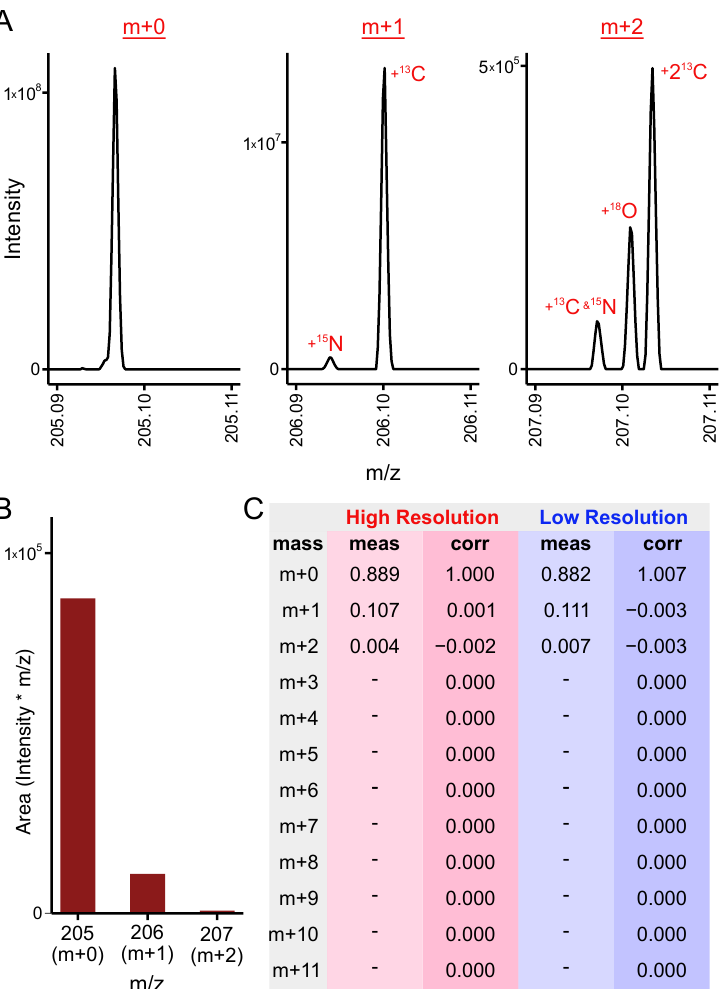
Figure 2. Correction of High- and Low- Resolution Data. ( A ) High-resolution mass spectrograph of tryptophan. ( B ) Low-resolution representation of the same mass spectrograph of tryptophan. ( C ) PolyMID correction of tryptophan MIDs for naturally occurring heavy isotope abundances in a 13 C tracer experiment. Abbreviations: meas: measured, corr: